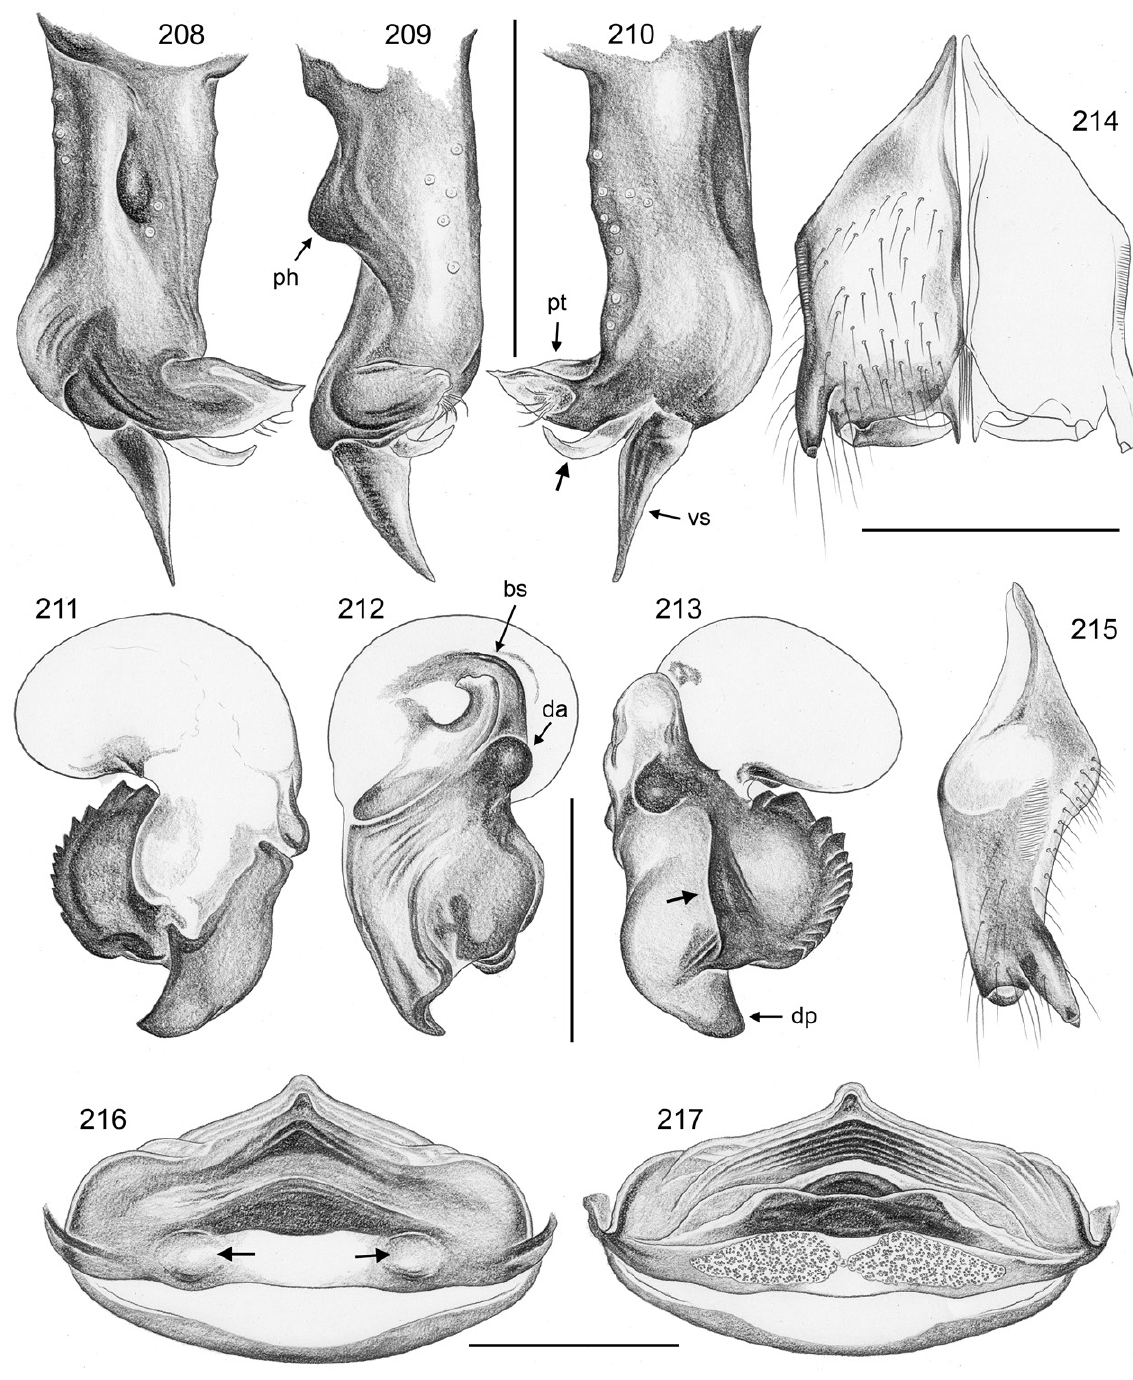
Figs 208–217. Maghreba saghro gen. et sp. nov.; male and female from Morocco, between Irherm and Tiferki (ZFMK Ar 22363, Ar 22364). 208–210 . Left procursus, prolateral, dorsal, and retrolateral views; arrow: semitransparent process. 211–213 . Left genital bulb, prolateral, dorsal, and retrolateral views; arrow: deep pocket. 214–215 . Male chelicerae, frontal and lateral views. 216–217 . Cleared female genitalia, ventral and dorsal views; arrows: pockets (pits). Abbreviations: bs = basal sclerite; da = dorsal apophysis; dp = dorsal process; ph = prolateral hump; pt = procursus tip; vs = ventral sclerite. Scale bars = 0.5